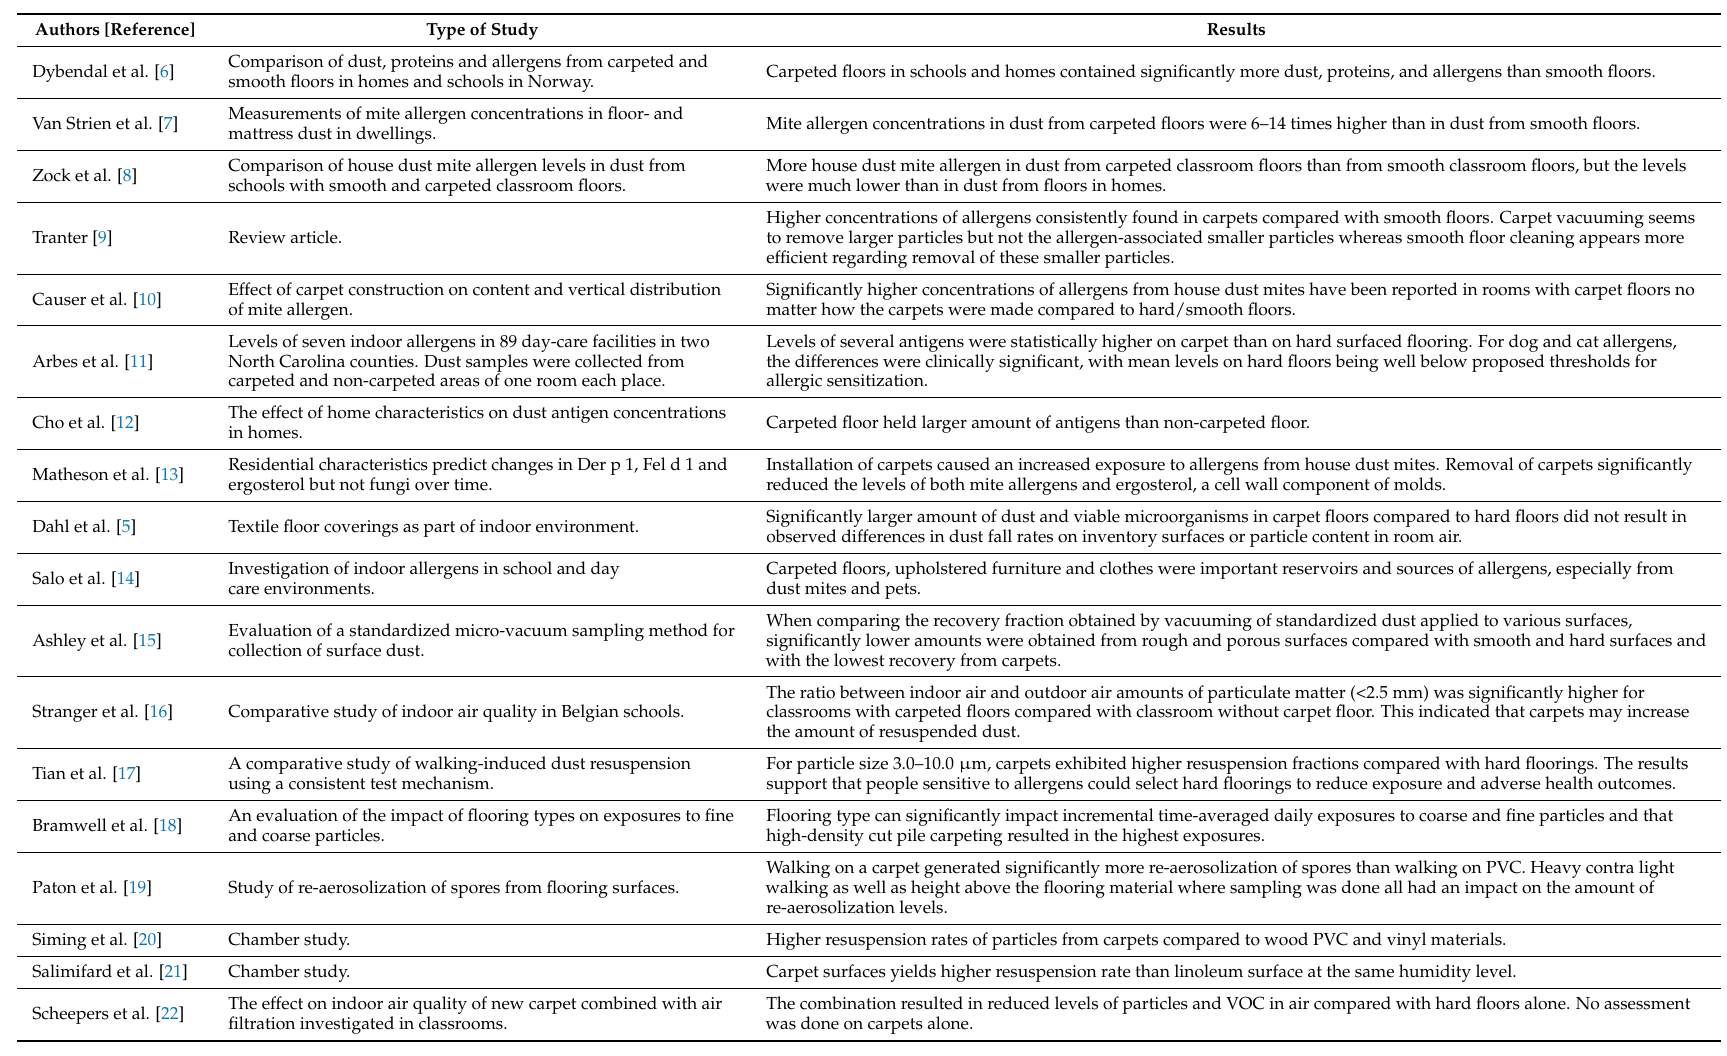
Table 1. Carpets as an exposure